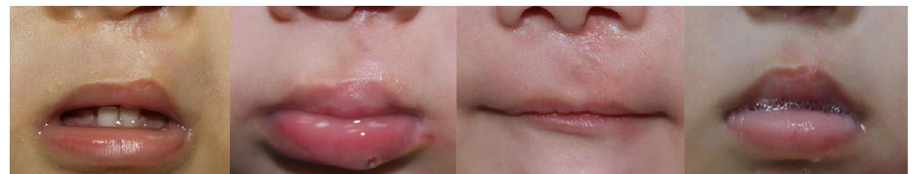
Figure 2. Babies from the control group (silicone sheet